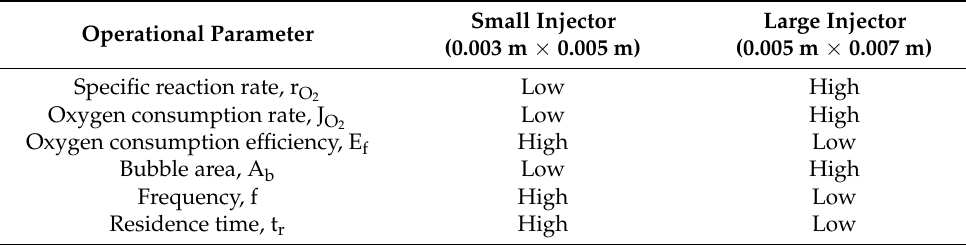
Table 7. Comparison of the operational parameters during white metal conversion experiments. The terms “high” and “low” are only used for comparison